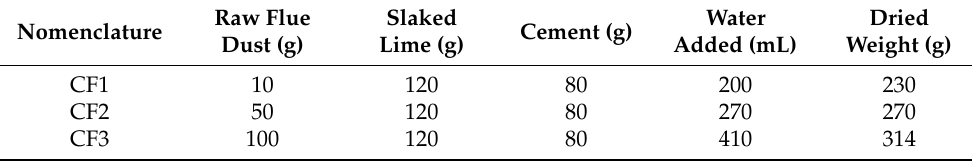
Table 1. Composition of different solidified materials